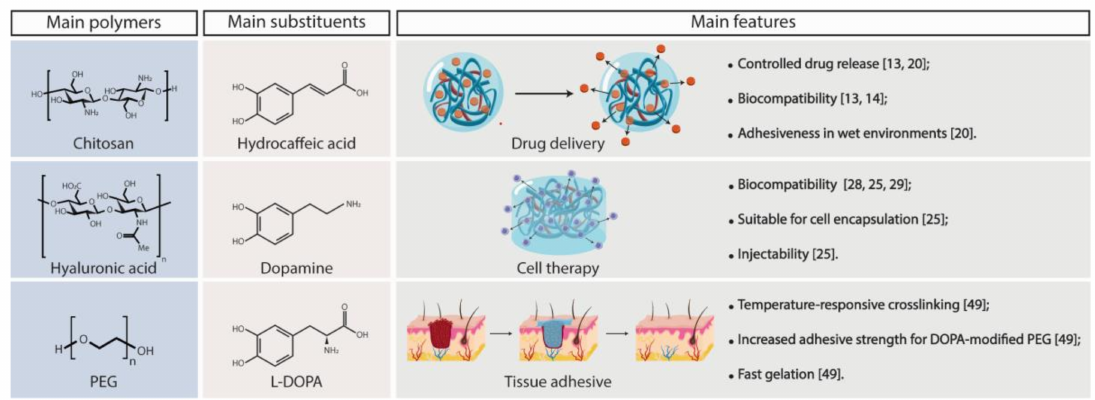
Figure 7. Chemical structures of polymers and substituents more frequently cited in this systematic review, as well as the main findings reported those